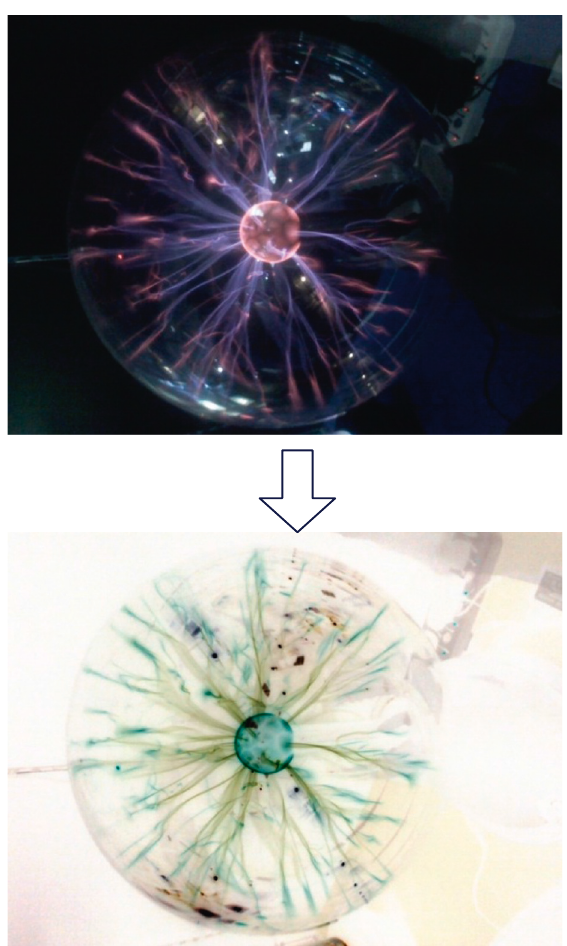
Figure 12: An example of a simulation image of physical immersion teaching based on digital simulation technology. Table 1: Effect verification of physical immersion teaching system based on digital simulation